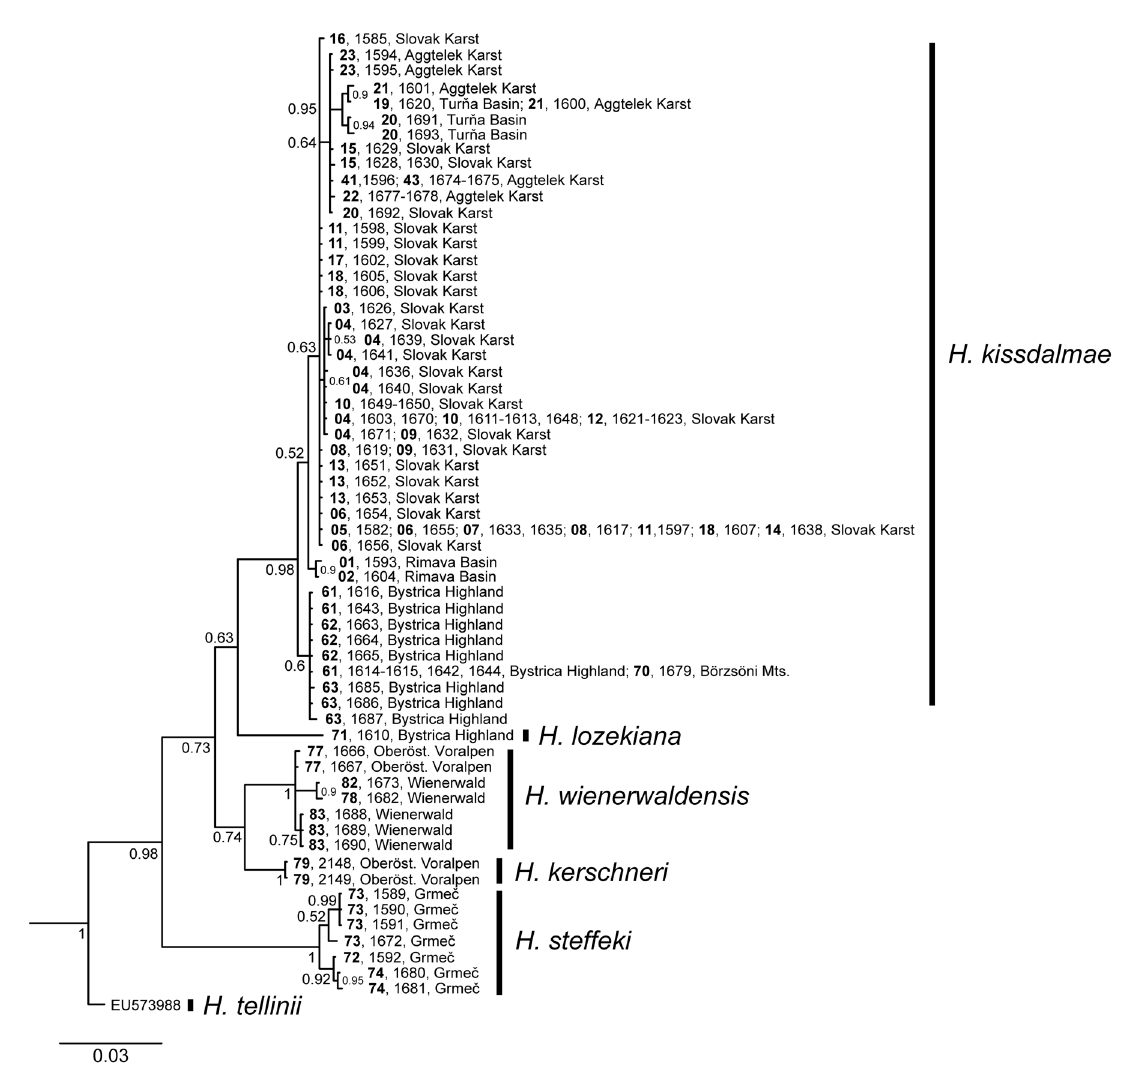
Fig. 6. Phylogenetic tree from Bayesian analysis in MrBayes based on 16S rRNA and ITS2 (outgroup pruned off). Specimens identified by two-digit locality code in bold, four digit individual DNA code, and orographic unit (see Table 1) or GenBank accession number (from Ponder et al. 2008); posterior probabilities at nodes; scale bar in substitutions per